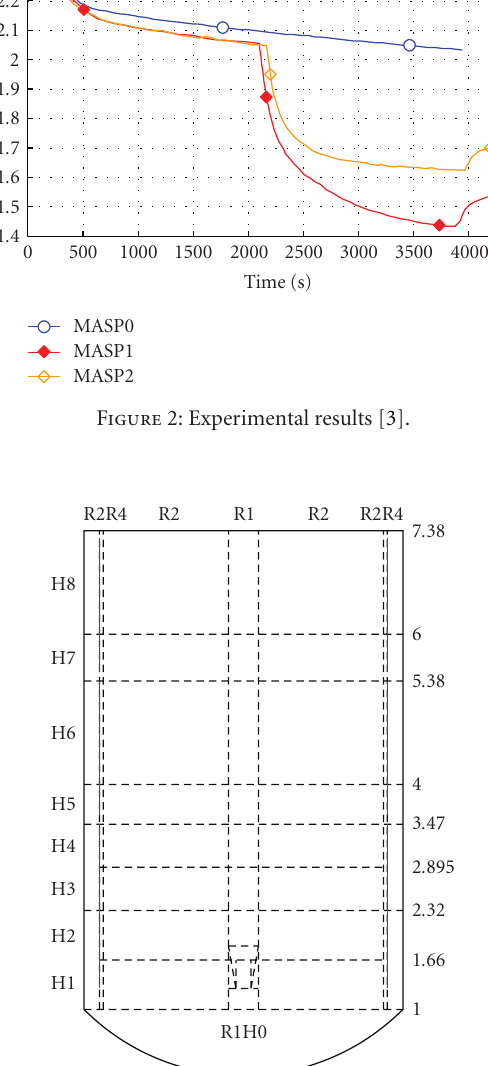
Figure 3: Nodalisation scheme for COCOSYS code.